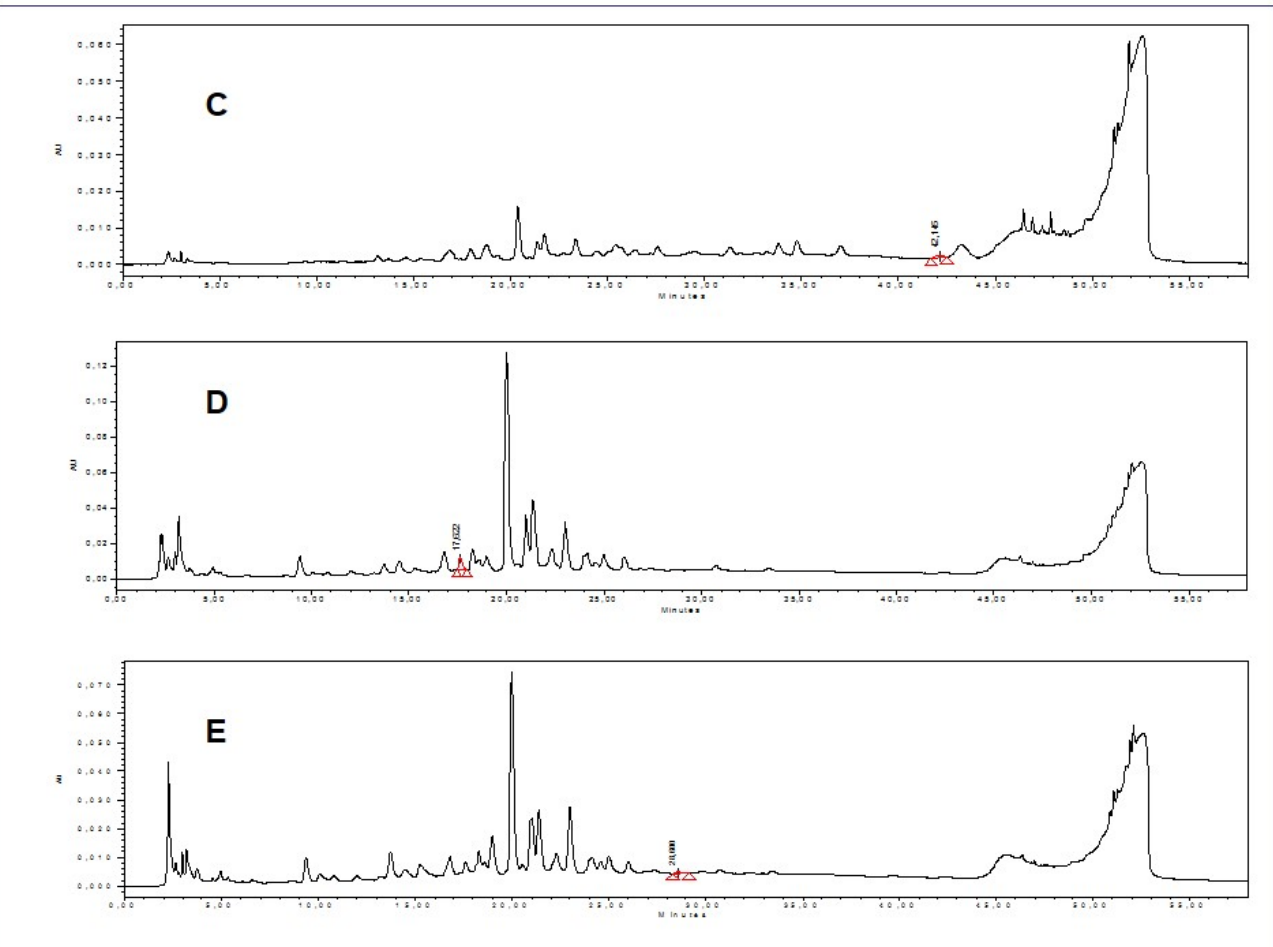
Figure 1. HPLC-PDA chromatograms. ( A ) t -ferullic acid, ( B ) 3-OH benzoic acid. ( C ) Syringic acid, Figure 1. HPLC ‐ PDA chromatograms. ( A ) t ‐ ferullic acid, ( B ) 3 ‐ OH benzoic acid. ( C ) Syringic acid, ( D ) Naringin, and ( E ) Harpagoside. ( D ) Naringin, and ( E ) Harpagoside.